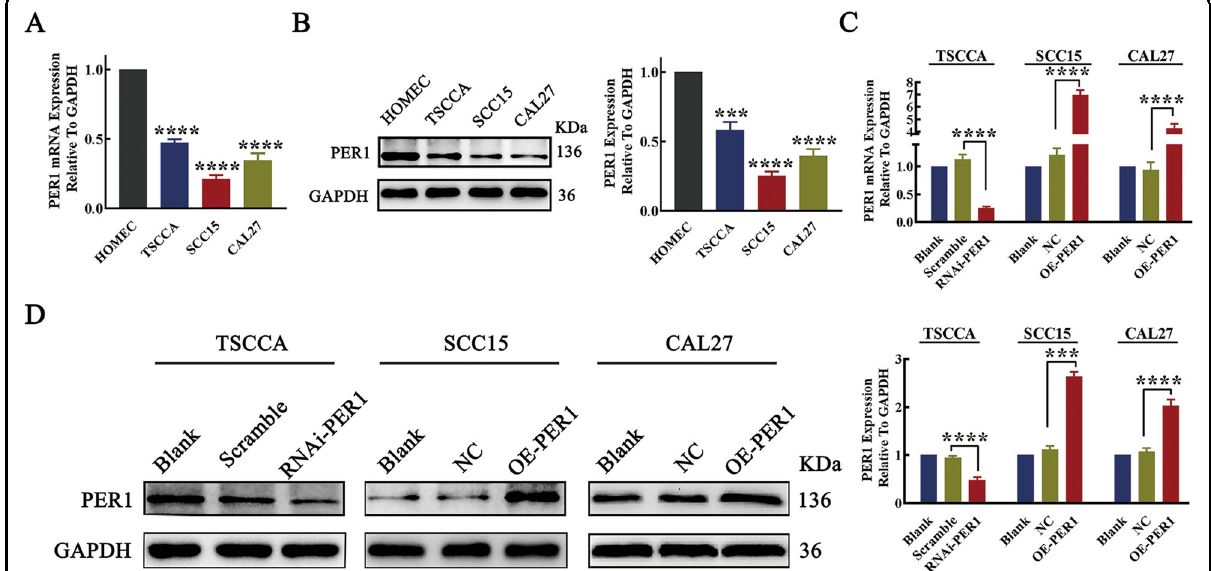
Fig. 1 The expression of PER1 was low in OSCC cells. A RT-qPCR results showed that the expression of PER1 mRNA in TSCCA, SCC15, and CAL27 cells was signi fi cantly lower than that in HOMEC cells; B western blot results showed that the expression of PER1 protein in TSCCA, SCC15, and CAL27 cells was signi fi cantly lower than that in HOMEC cells; C , D RT-qPCR and western blot results showed that the mRNA and protein expression levels of PER1 in RNAi-PER1-TSCCA cells were signi fi cantly decreased, while those in OE-PER1-SCC15 and OE-PER1-CAL27 cells were signi fi cantly increased. All data are from three independent experiments. The data are presented as the mean ± SD values ( n ≥ 3). * P < 0.05; ** P < 0.01; *** P < 0.001; **** P <